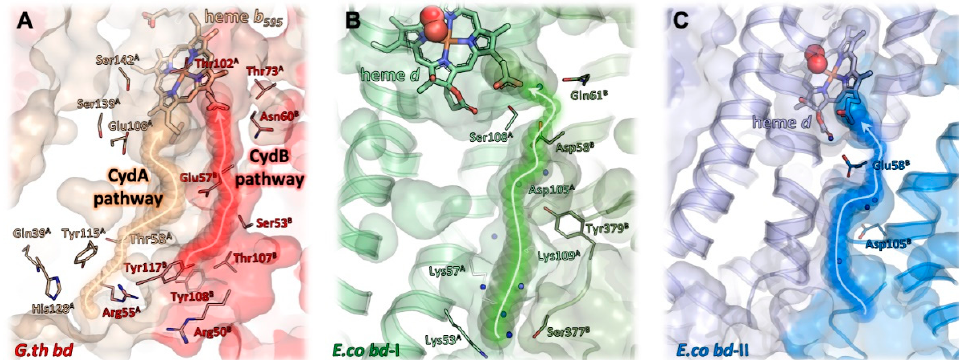
Figure 6. Proton pathways in bacterial bd oxidases to the heme triangle. ( A ) G. thermodenitrificans features a pathway along the CydA/CydB interface, termed the CydB pathway (red). A second pathway running through CydA has been proposed as well, termed CydA pathway (light beige). ( B ) A pathway in E. coli bd -I (olive green), largely equivalent to the CydB pathway in G. thermodenitrificans , is lined by several hydrophilic amino acid sidechains (shown as thick lines) and directs water molecules (i.e., protons) to the propionate of the active site heme d . Numerous water molecules (blue spheres) have been found in that channel, highlighting its full accessibility. ( C ) E. coli bd -II features a comparable channel. But due to the much wider cavity protruding deeply into the protein core, the actual channel requires only two glutamate sidechains (shown as sticks) to coordinate water molecules and guide them to the active site. Here again, the presence of water molecules illustrates the accessibility of solvent molecules.